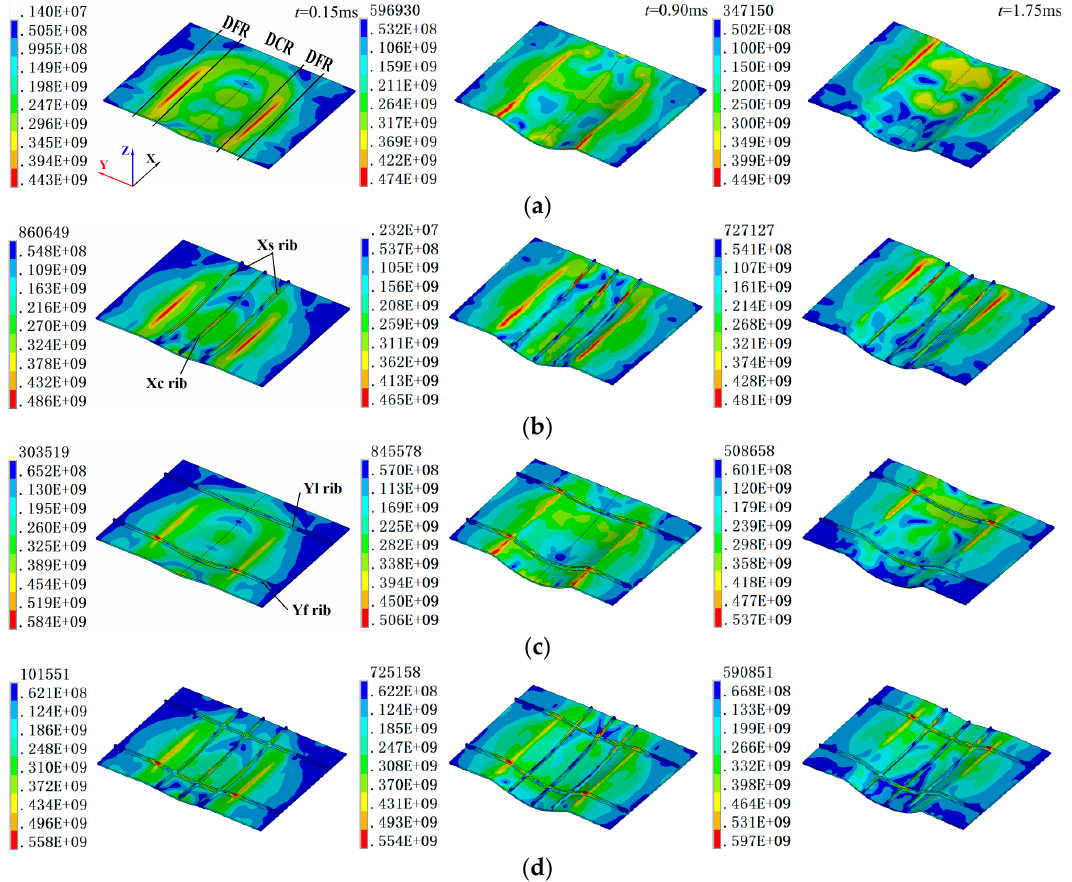
Figure 10. Equivalent von Mises stress distribution of four panels in the early stage of each discharge (Pa): ( a ) FP; ( b ) XP; ( c ) YP; and ( d ) GP.